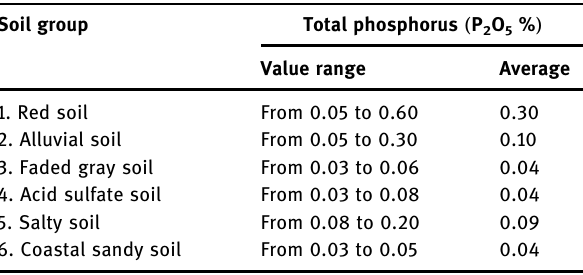
Table 10: The phosphorus content limitations for each soil